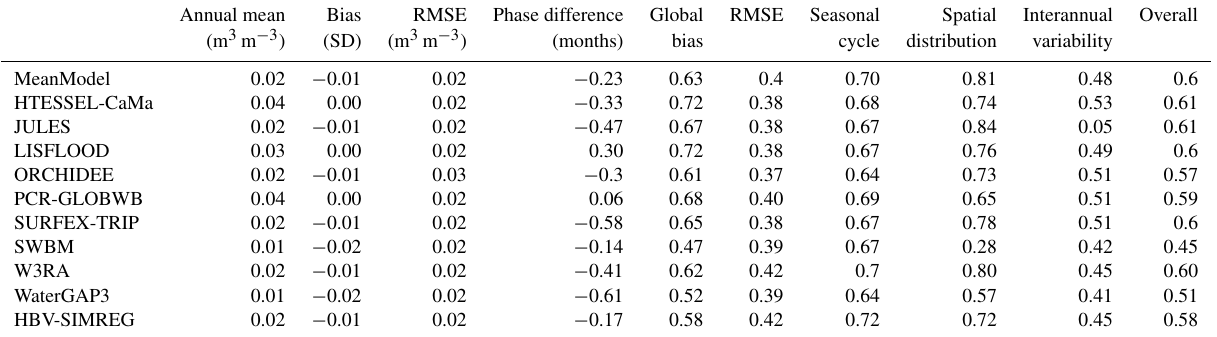
bias cycle distribution variability